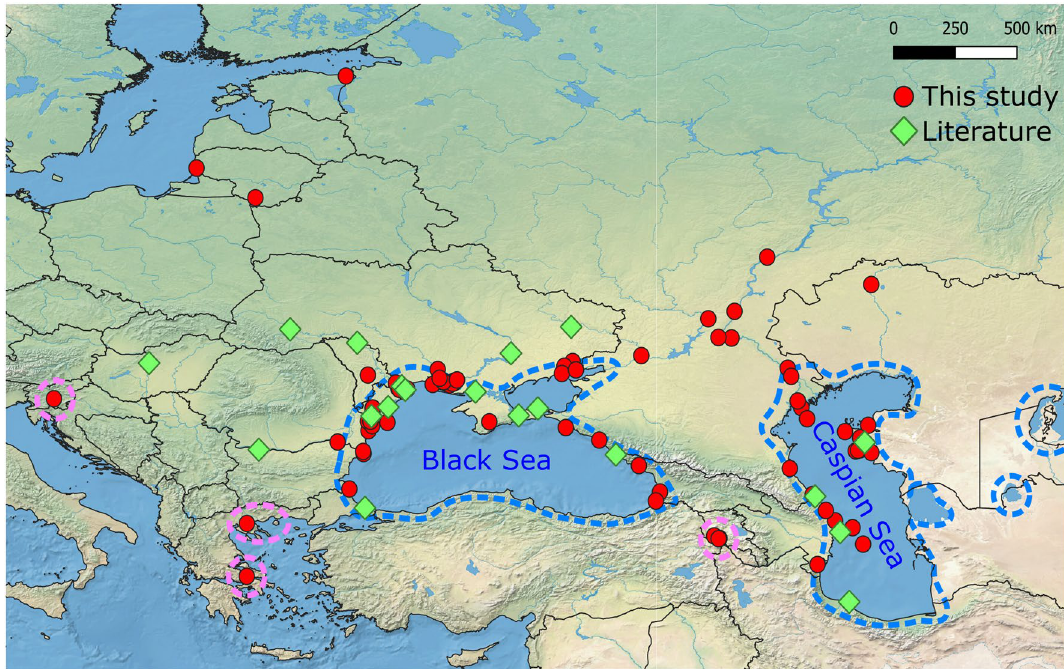
Figure 1. Map of sampling localities. Red dots indicate sampling points from this study while green rhombi indicate literature data. Blue dashed lines indicate the native Ponto-Caspian range. Pink dashed lines indicate areas that contain endemic Ponto-Caspian amphipods which are biogeographically separated from the mother